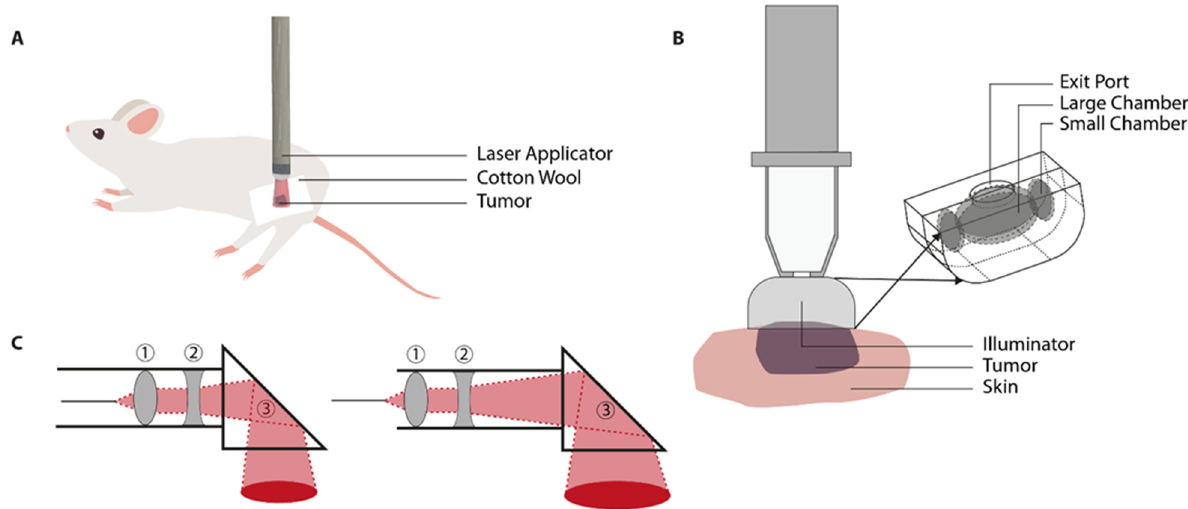
Figure 4. Illustrations of the near-infrared laser light device for hyperthermia application. ( A ) This system is based on a single laser applicator. The healthy tissues can be shielded either by cotton wool or through the use of an illuminator; ( B ) uniform laser light can be applied through the use of an illuminator. By passing the light through the chambers, reflections result in spatially homogenized light exiting the device; ( C ) laser beam adjustments can also be made through the use of two lenses and one prism. By moving the lenses (1,2) further from the prism (3) the beam width expands. Image B is adapted from Dou et al. [101] and image C is adapted from Willerding et al. [41].